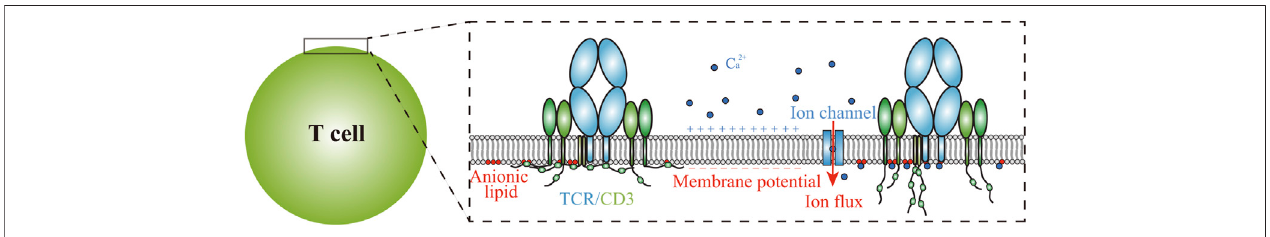
FIGURE3| BioelectriccuessurroundingTCRsonTcellmembranes.ThebioelectriccuesthatpotentiallyaffectTCRfunctionsincludemembranepotential,ion fl ux andanioniclipidsintheinner cellmembranes.Ca 2+ fl uxinducedbyTCRtriggeringimpedestheelectrostaticinteractionbetweenanioniclipidsandthebasicrichregions in CD3